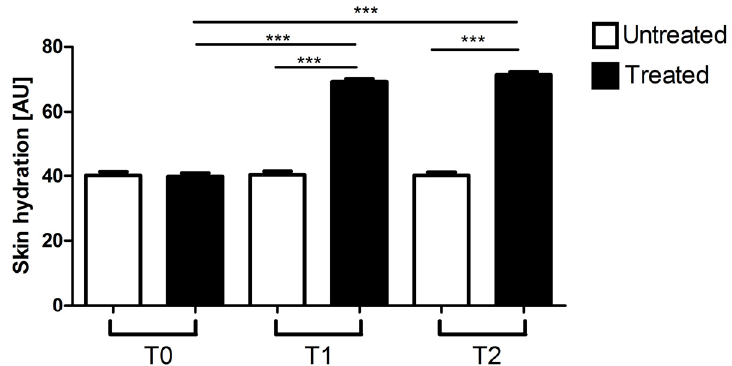
Figure 4. Skin hydration at baseline (T0), after one application (T1) and after 4 applications (T2) of the test product in the clinical trial subjects. Untreated (in white) and treated (in black) sides are shown. *** indicates P < 0.0001.